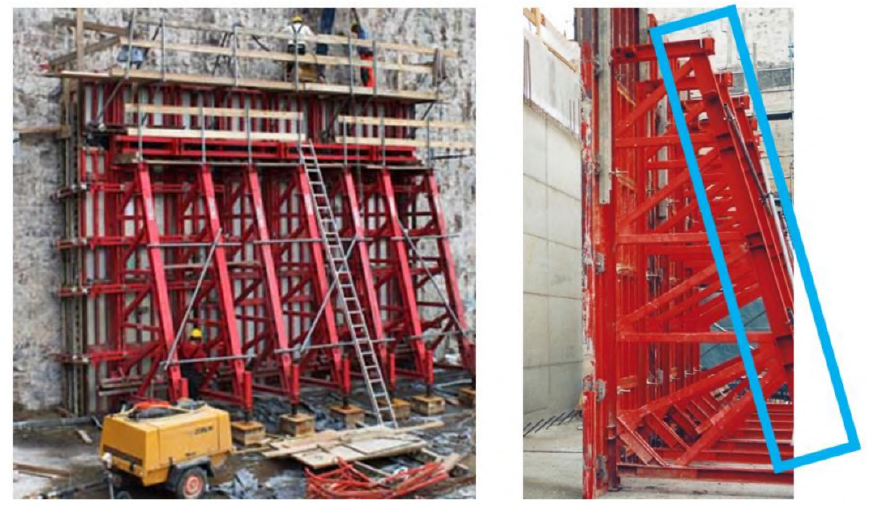
Figure 8. One-sided bracket product and